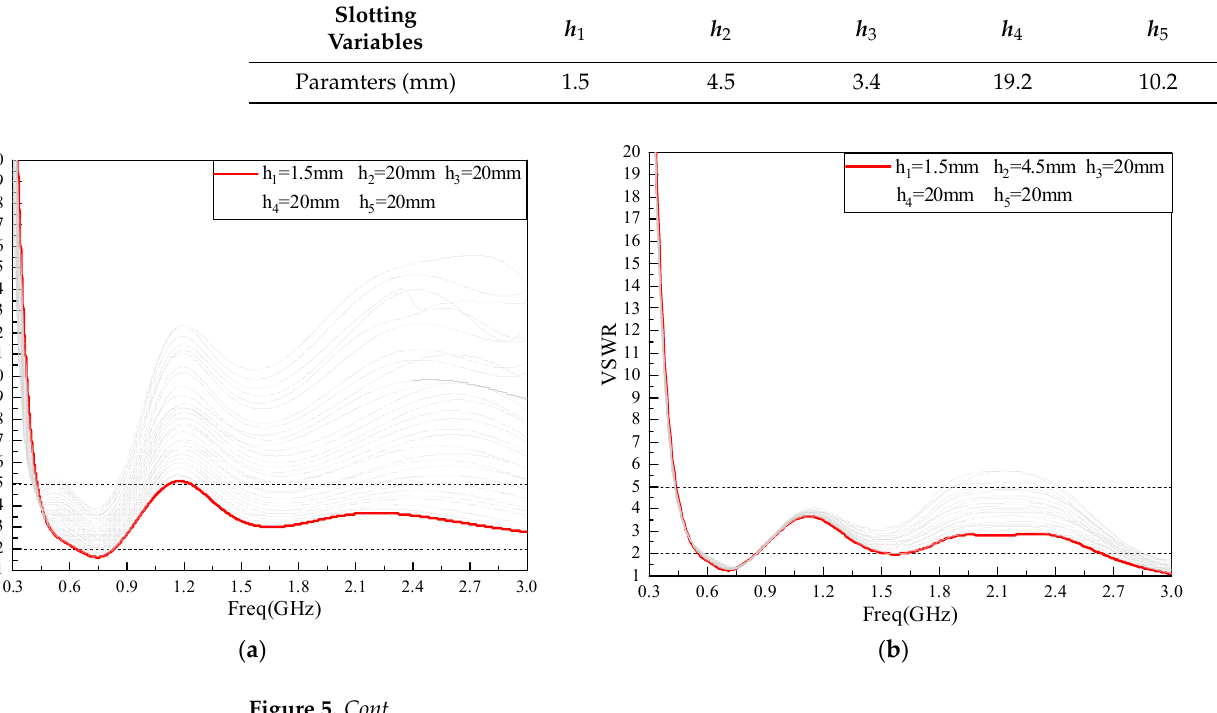
Figure 4. Optimization Diagram of Meandering Technology. Table 1. Optimization results for the five rectangular length parameters. Slotting